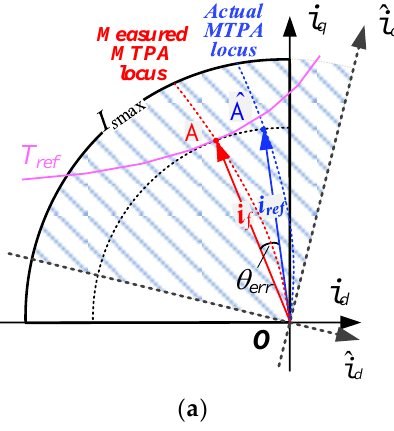
Figure 8. Current mapping deviation caused by sampling delay: ( a ) sufficient voltage margin state; ( b ) flux-weakening state.